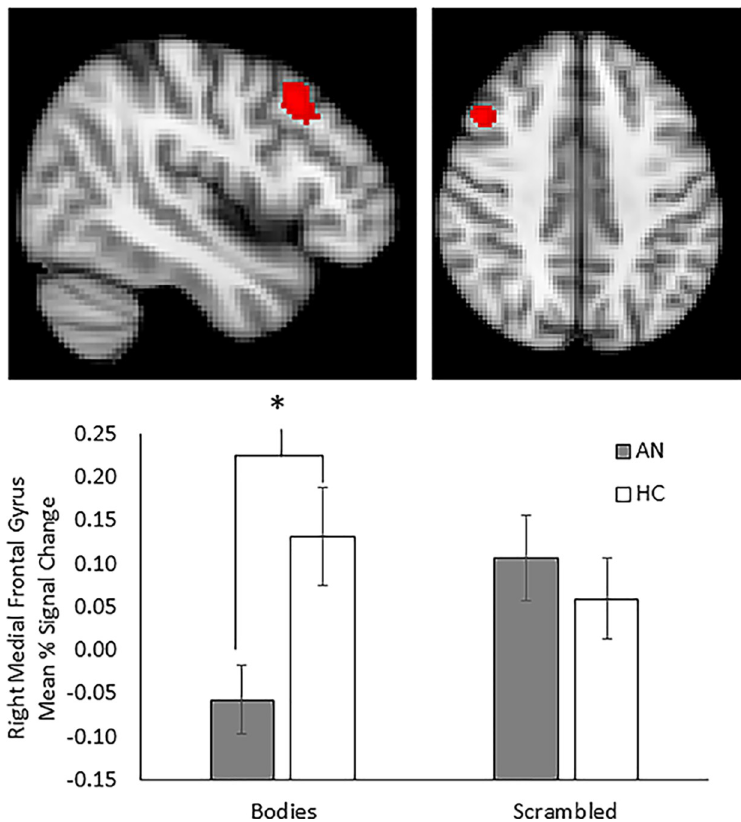
Fig 5. Whole-brain group contrast comparing activation of bodies relative to scrambled images. Weight restored participants with a history of anorexia demonstrated decreased activation in the right middle frontal gyrus relative to controls when viewing whole body images relative to scrambled images. Slices are shown at X = 46 (top left) and Z = 42 (top right). Mean percent BOLD signal change extracted from functional cluster in the right middle frontal gyrus for bodies and scrambled images, plotted against group (bottom panel). Participants with a history of anorexia exhibited significantly decreased activation to bodies relative to control participants, whereas activation to scrambled images did not differ between groups. Error bars represent standard error of the